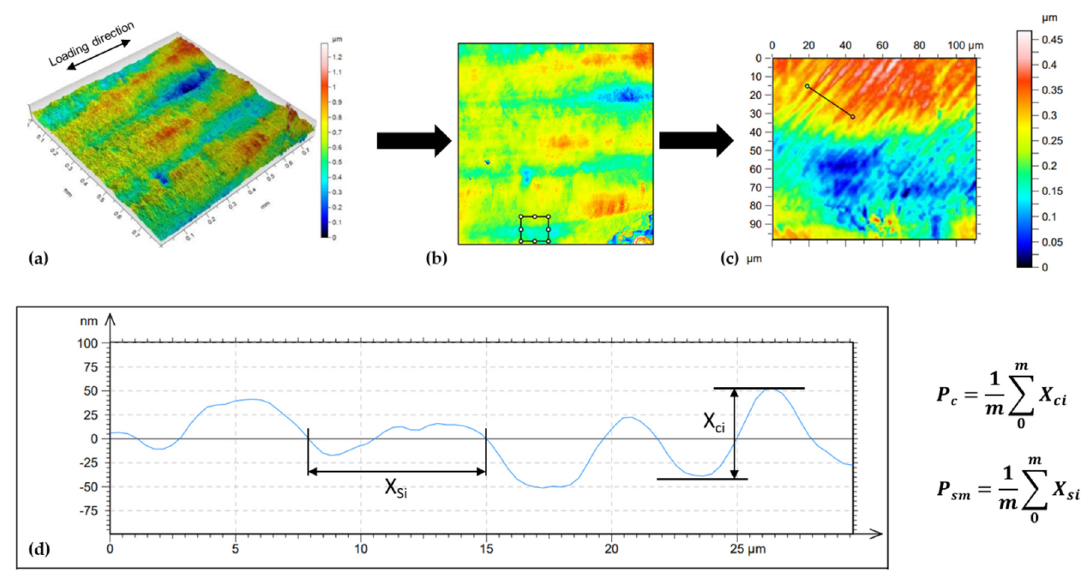
Figure 2. Interferometric mapping of a High-Li aluminum alloy. ( a ) 0.8 mm × 0.8 mm 3D surface mapping. ( b ) In plane projection of the surface heights. ( c ) zoom on a 100 µm × 100 µm area. ( d ) Typical line profile is taken perpendicular to the slip bands from which the quantities P c and P sm are evaluated.